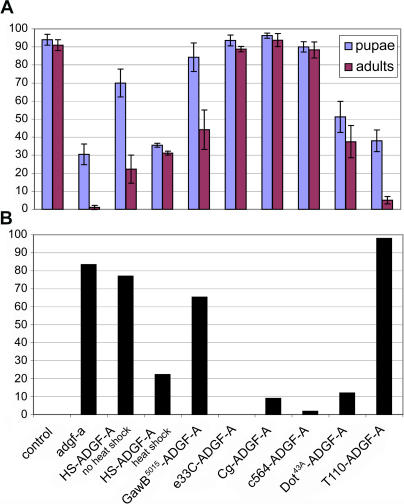
Rescue of the adgf-a Mutant Phenotype by Expression of ADGF-A in Different Tissues(A) Percentage of pupae (blue bars) and adult flies (purple bars) demonstrating the larval and pupal survival, respectively, of the adgf-a mutant flies rescued by expression of transgenic ADGF-A in different tissues. Along the x-axis (which is shared with [B]), the rescue experiments are shown (marked by the Gal4 driver used for expression of ADGF-A except for first three sets of bars—the first set presents only an adgf-a mutant, the second an adgf-a mutant carrying HS-ADGF-A construct without heat shock, and the third with heat shock) and the y-axis represents percentage of pupae and adult flies out of the total number of transferred first-instar larvae of particular genotype. Each experiment was repeated at least four times (with 20–30 animals in each vial) and the standard error is shown.(B) Percentage of late third-instar larvae with melanotic tumors. The x-axis is shared with (A) (described above). The y-axis shows the percentage of larvae with tumors out of all larvae of each genotype examined for (A).